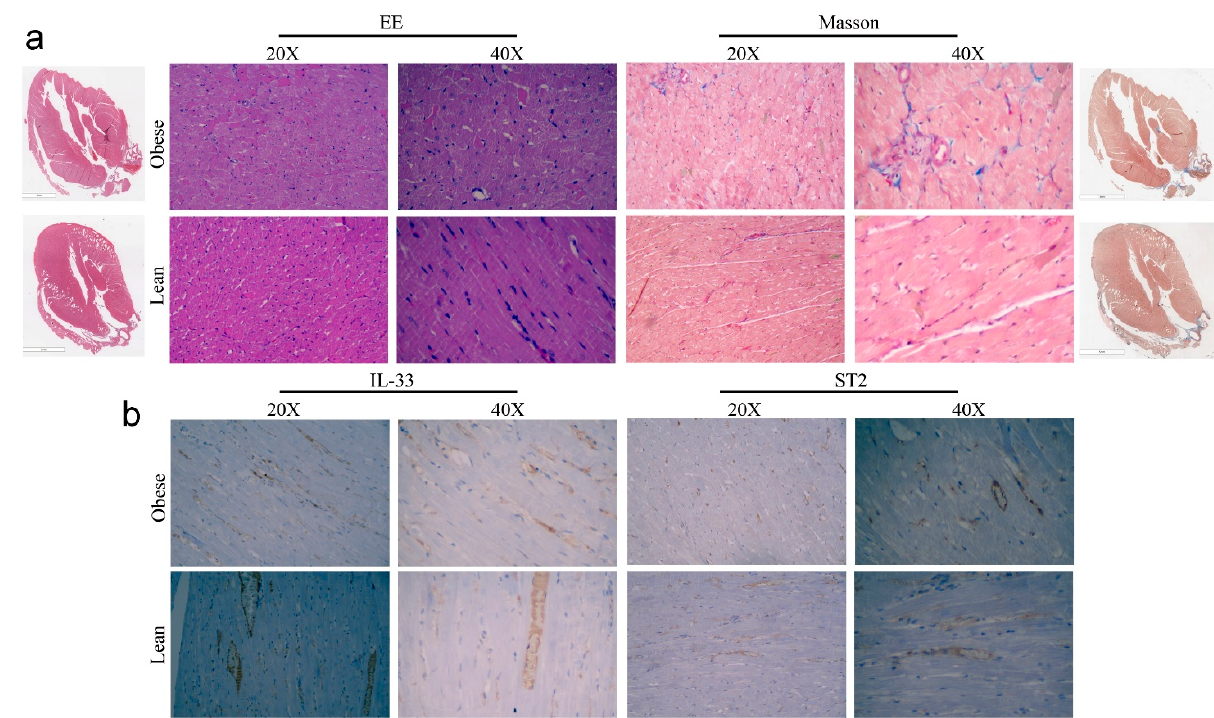
Figure 4. Pictures of ( a ) Haematoxylin and Eosin and Masson’s staining and ( b ) IHC analysis of IL-33 and ST2 expression in cardiac biopsies of ZR.